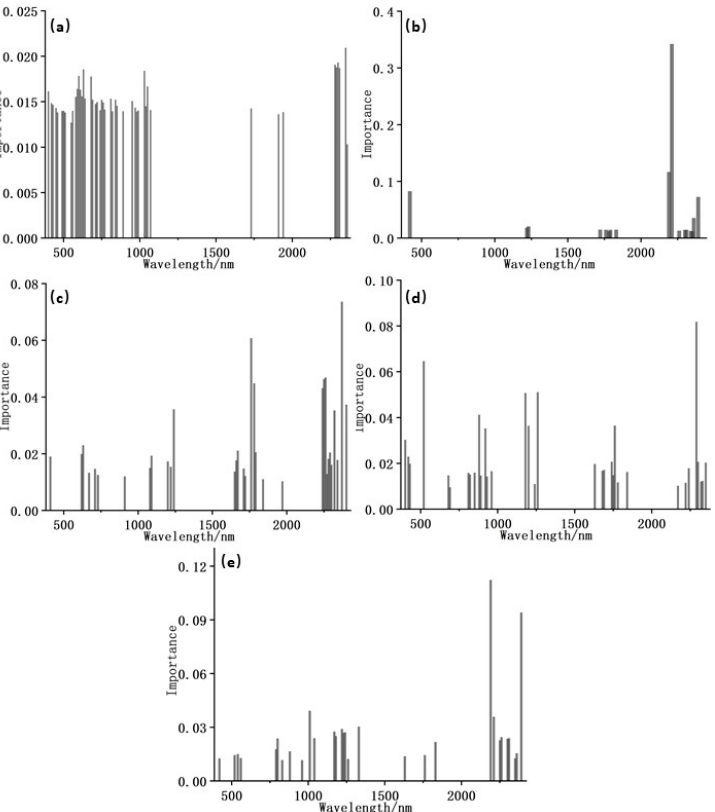
Figure 5. Distribution of optimal characteristic bands after RF selection: ( a ) Initial-GARF; ( b ) CR- GARF; ( c ) CR-FD-GARF; ( d ) CR-SD-GARF; ( e ) CR-LN-GARF.